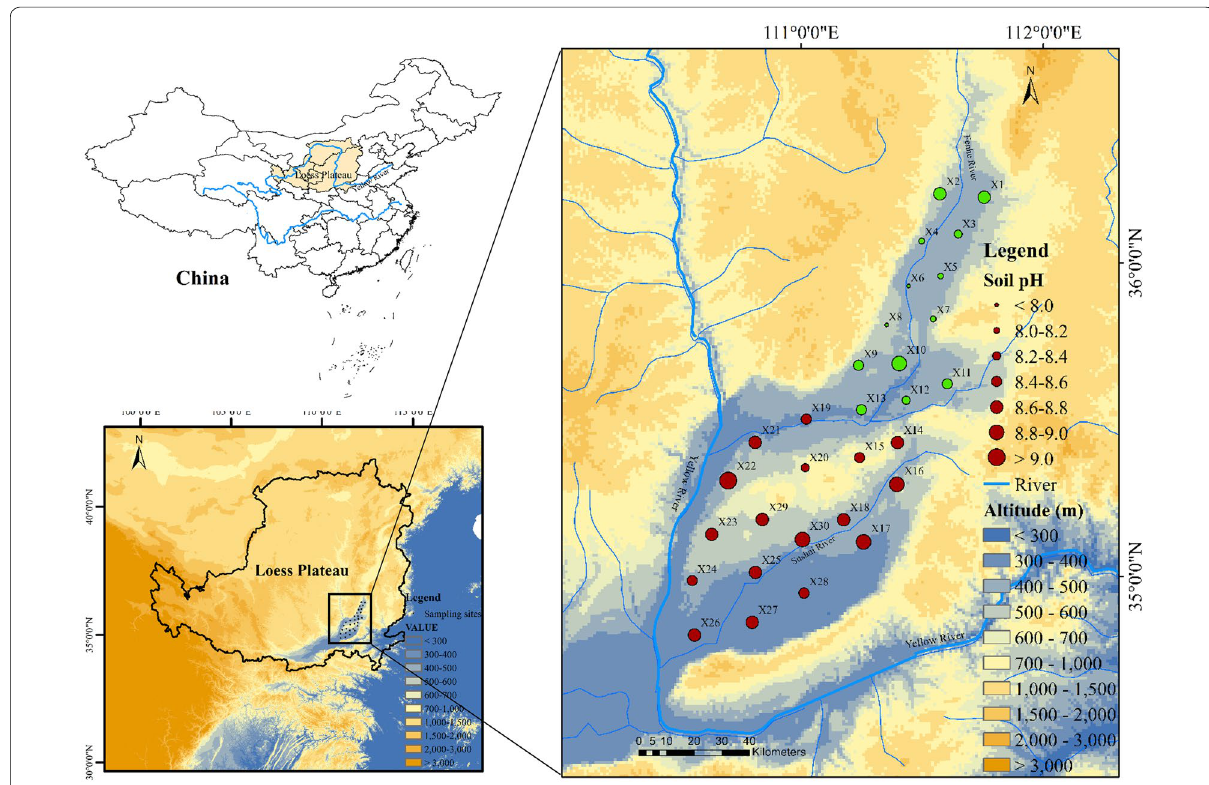
Fig. 1 Sampling locations with altitudes and soil pH in the Loess Plateau,